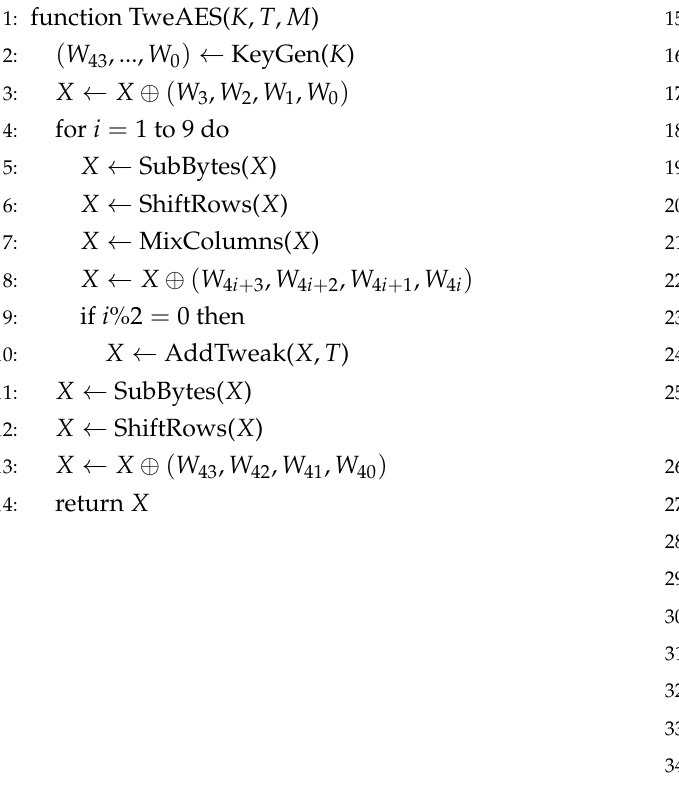
Algorithm 3 TweAES-128 Algorithm [16].